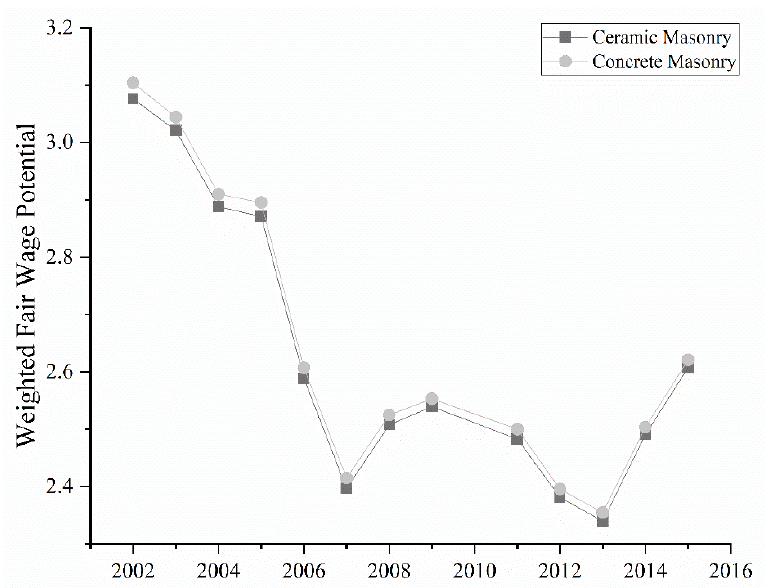
Figure 6. Weighted fair wage potential values for the ceramic masonry and concrete masonry projects.